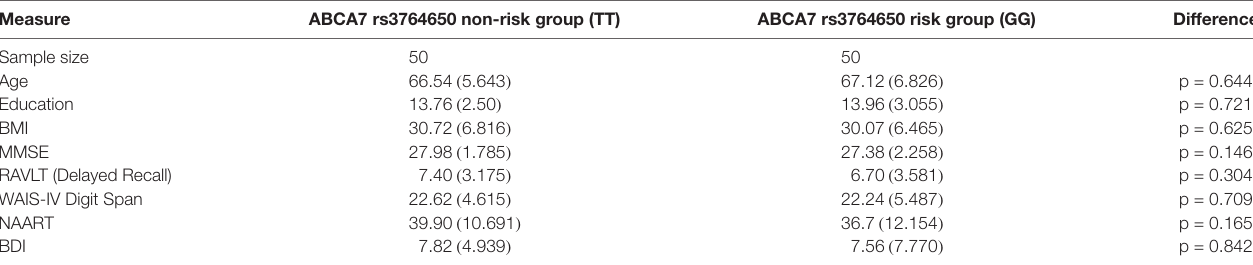
TABLE 1 | Demographics and neuropsychological